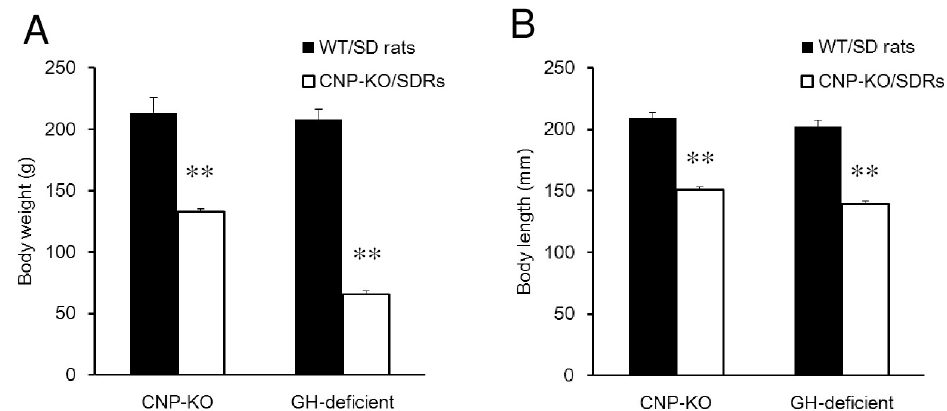
Fig 1. Weights and lengths of WT, CNP-KO, SD rats and SDRs. (A) Body weights and (B) lengths of female WT, CNP-KO, SD rats, and SDRs at 9 weeks of age. Body weights and lengths of WT and CNP-KO rats at 9 weeks of age (N = 3 each), and of SD rats and SDRs at 9 weeks of age (N = 5 each). Data are expressed as the means ± SD. �� , P < 0.01 vs. WT or SD rats using Student’s t